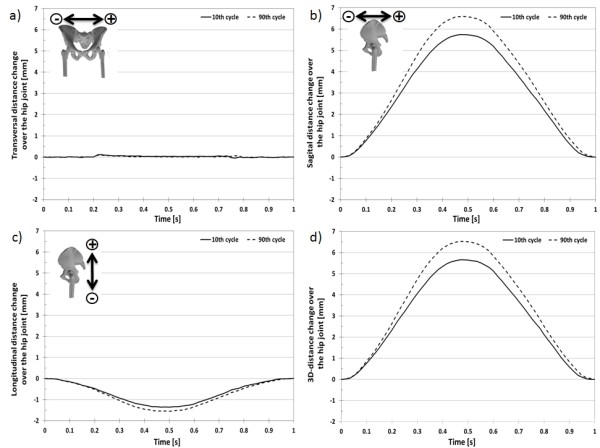
3D-deformation around the hip joint. 3D-movement between the two markers at the acetabulum and femur at the 10th and 90th loading cycle with a sinusoidal load between 100N and 900N.